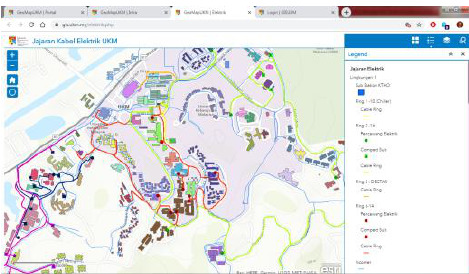
Figure 8. An example of a module (GUI, list of data and analysis) for Electric Cable module (on surface/underground).